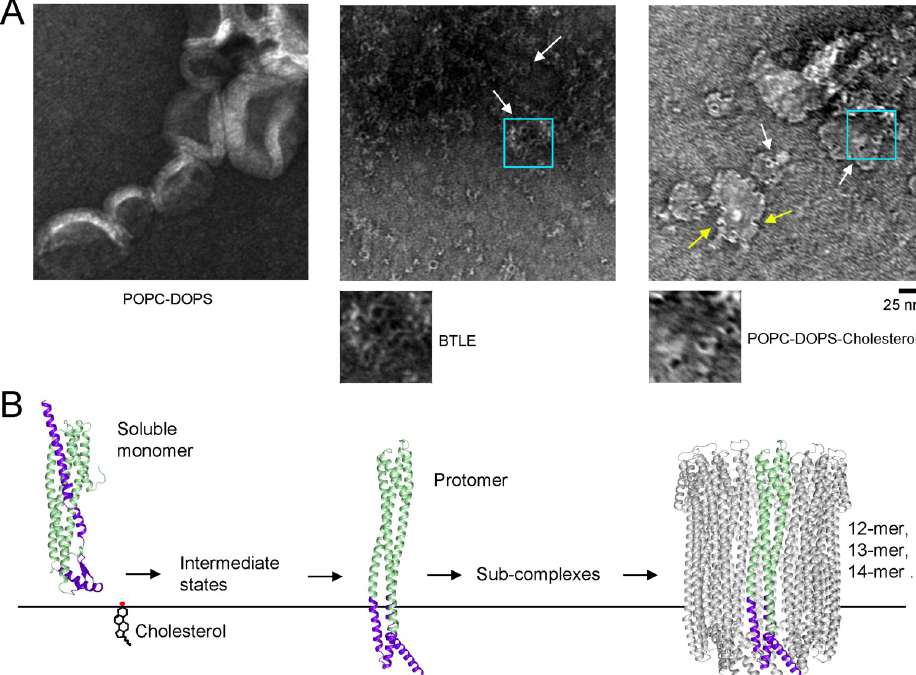
Fig 4. ClyA forms pores on cholesterol-containing liposomes. ( A ) POPC-DOPS, POPC-DOPS-cholesterol or BTLE liposomes were incubated ON with 5 μ M ClyA (-tag) at 4˚C (pH 7.4) and examined with negative staining. ClyA forms pore structures on POPC-DOPS-cholesterol and BTLE liposomes, but not on POPC-DOPS liposomes. Representative pores are indicated with white arrows. Regions within the cyan boxes are enlarged for clear visualization. Crescent structures are indicated with yellow arrows. ( B ) Model for the assembly of ClyA pore complexes from the soluble monomer. The corresponding transmembrane elements in the soluble monomer and one protomer are colored